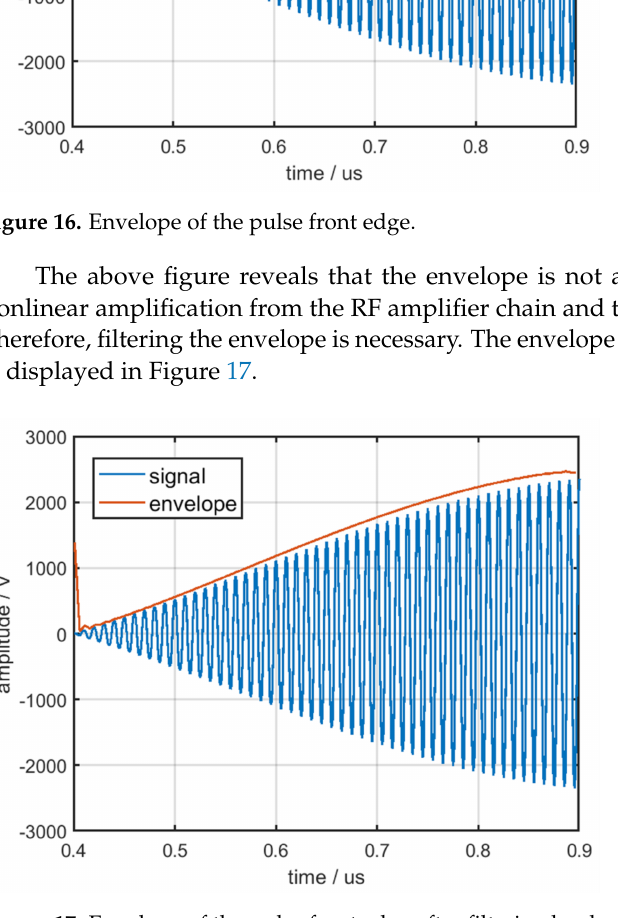
Figure 17. Envelope of the pulse front edge after filtering by